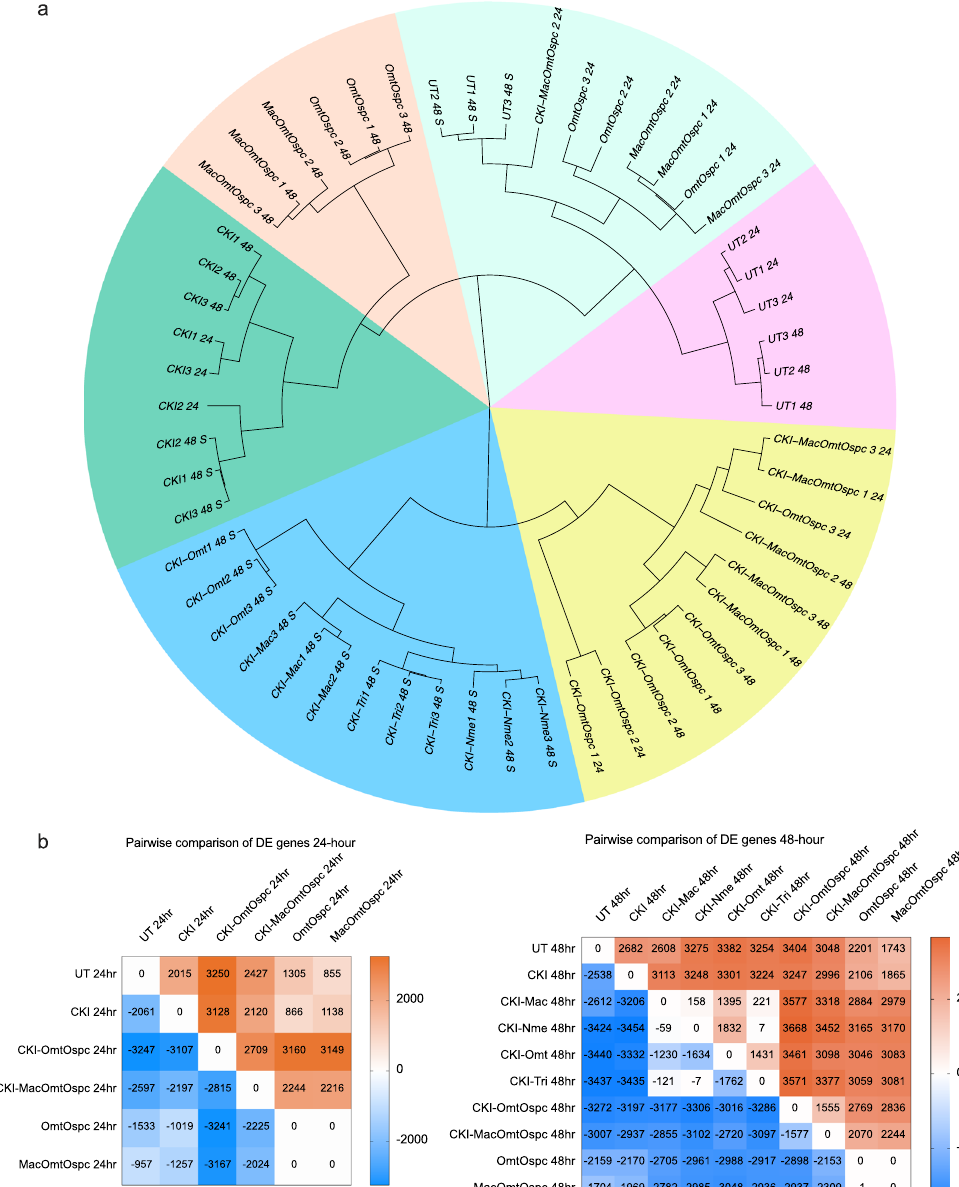
Figure 4. Gene expression clustering and summary of differential gene expression. ( a ) Clustering of treated samples based on gene expression, calculated as transcripts per million using Ward’s hierarchical cluster analysis (Ward.D2) method. Number of DE genes (FDR < 0.05 according to edgeR) associated with each treatment was calculated using pairwise comparison at ( b ) 24-hour and 48-hour timepoints. Treatments were compared column versus row. Up-regulated genes are shown in shades of red and down-regulated genes are shown in shades of